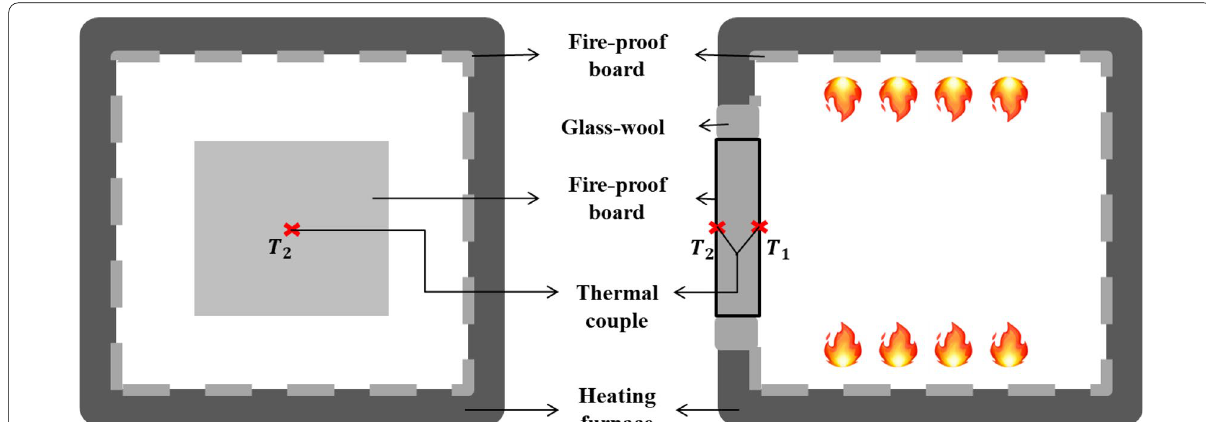
Fig. 24 Test concept for thermal conductivity of mortar and board (Lim et al. 2017).